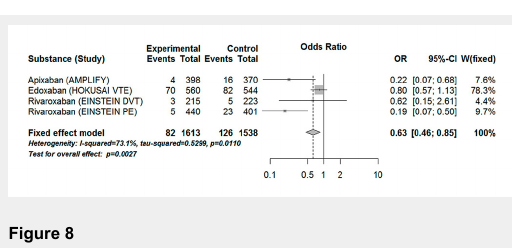
Figure 8 Forest plot of composite safety endpoint major bleeding and clinically significant non-major bleeding in patients with VTE aged 75 years or over. CI = confidence interval; experimental = direct oral anticoagulants; control = vitamin K